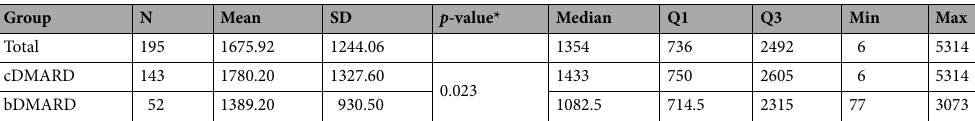
Table 4. Observation time (days) from the initiation of treatment in RA patients with conventional or biologic DMARD to VTE. t-test only included cases with VTE (not including those without VTE). N =